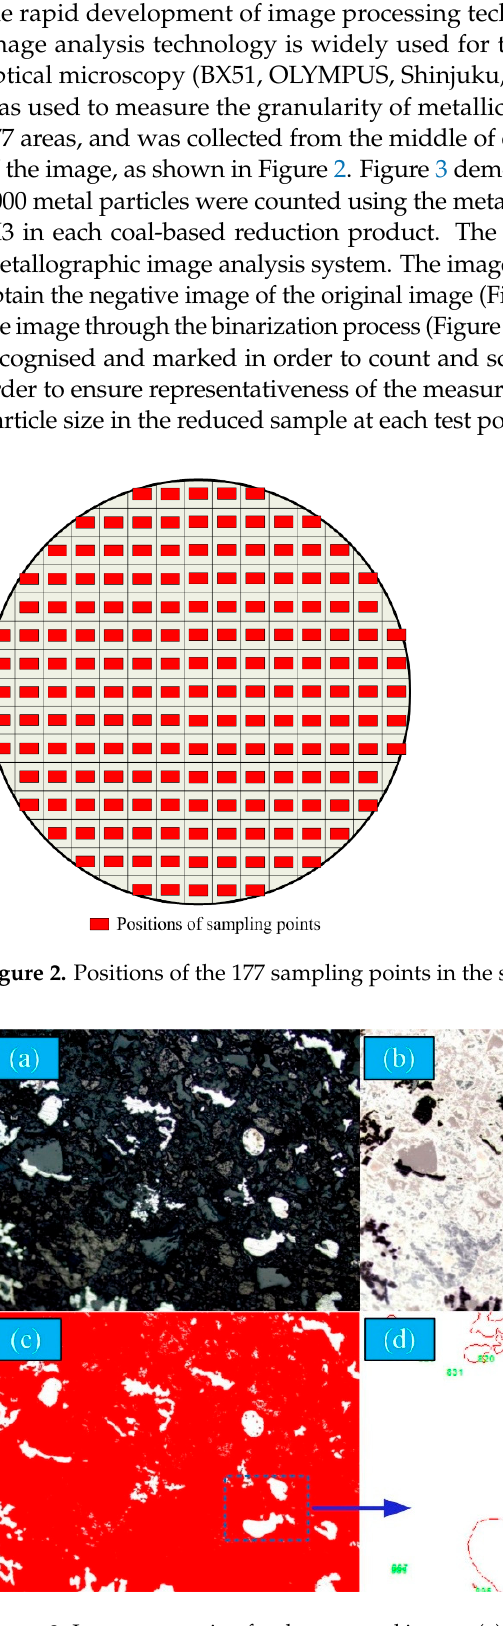
Figure 3. Image processing for the captured image. ( a ) Original image ( b ) Grey value image ( c ) Binary image ( d ) Count image.